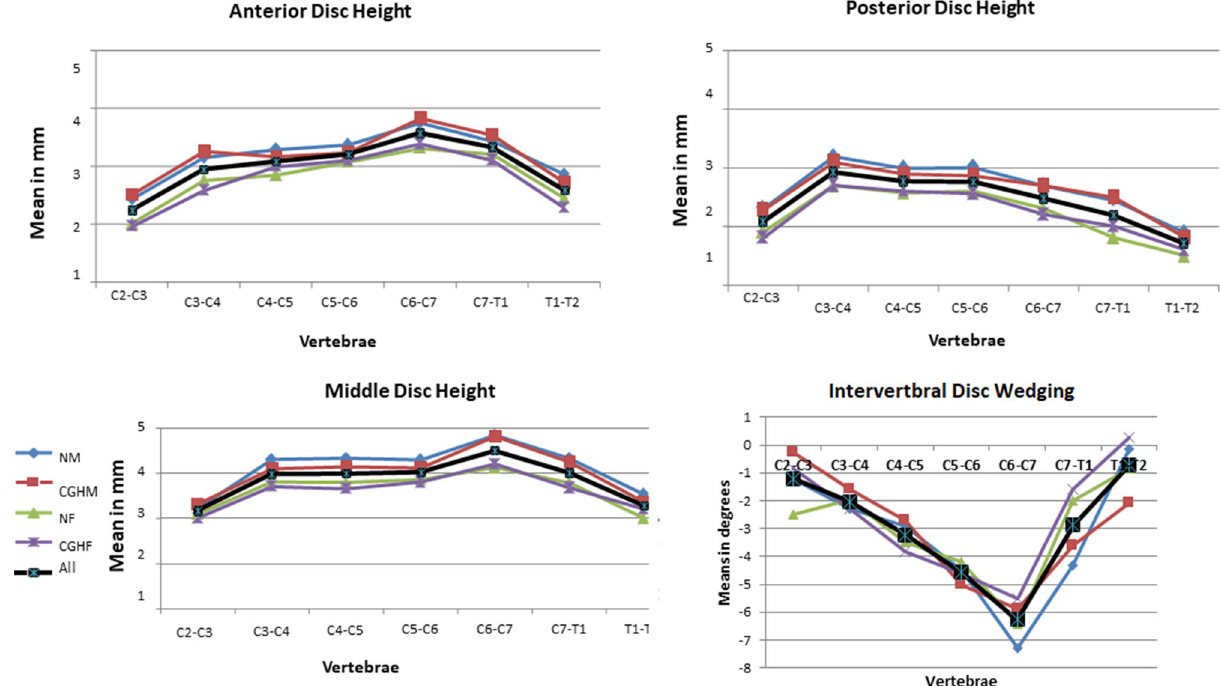
Figure 1. Intervertebral disc shape variation along the cervical spine. NM normal males, CEHM cervicogenic headaches males, NF Normal females, CEHF cervicogenic headaches females, All all individuals combined.